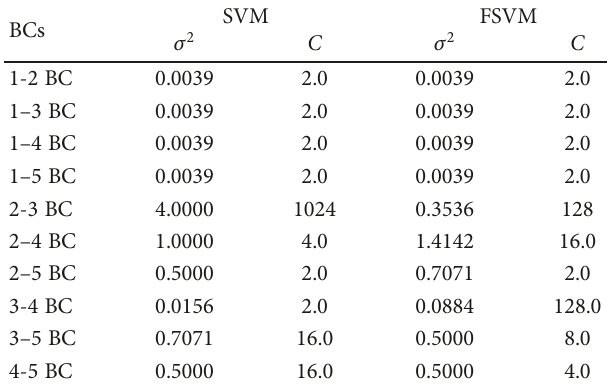
Table 10: Optimal parameters for respective BCs.